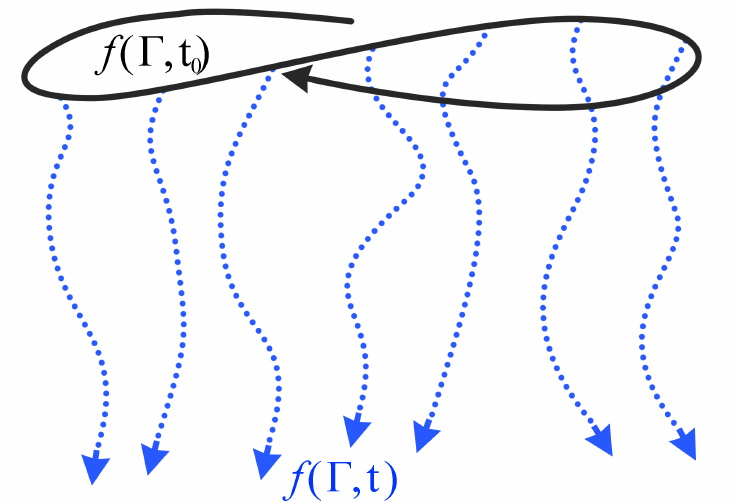
Figure 5. Sketch representing the NEMD paradigm. The continuous line represents the trajectory sampling the initial PDF f ( Γ , t 0 ) , at the initial time, t 0 . The pointed lines represent the indepen- dent trajectories evolved in time up to t sampling f ( Γ , t ) from the initial configurations belonging to f ( Γ , t 0 )